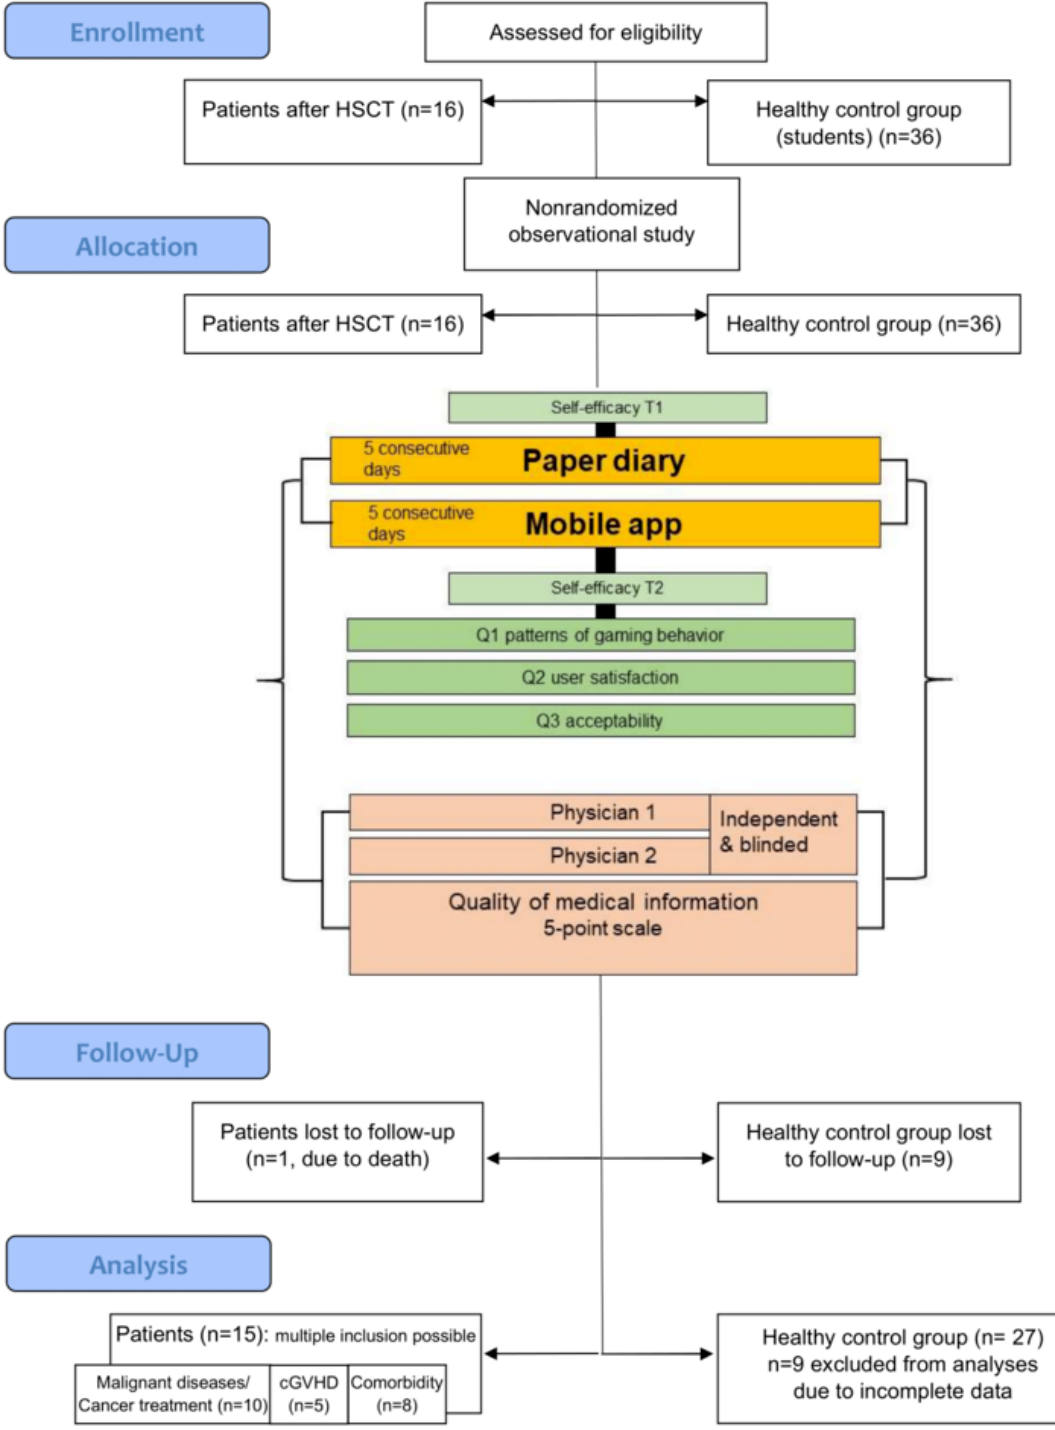
Figure 1. Study overview. The diagram was adapted from the CONSORT (Consolidated Standards of Reporting Trials) 2010 flow diagram (Eysenbach, 2011, and CONSORT, 2020). Malignant diseases include all malignant underlying diseases. Comorbidity is deemed severe when graded as 3-4 on the Common Terminology Criteria for Adverse Events (CTCAE). cGVHD: chronic graft-versus-host disease; HSCT: hematopoietic stem cell